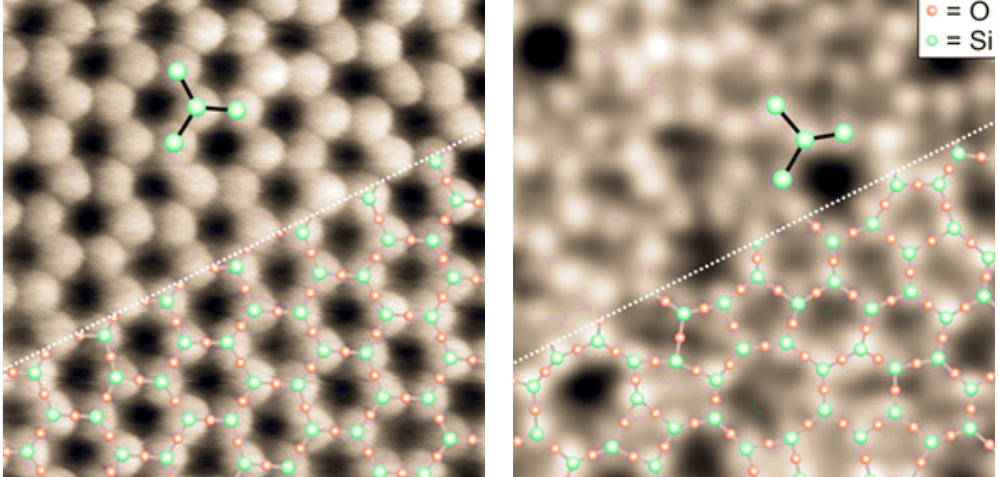
Fig. 4 Comparison between the ordered structure of crystal and the disordered – amorphous– structure of glass. Both